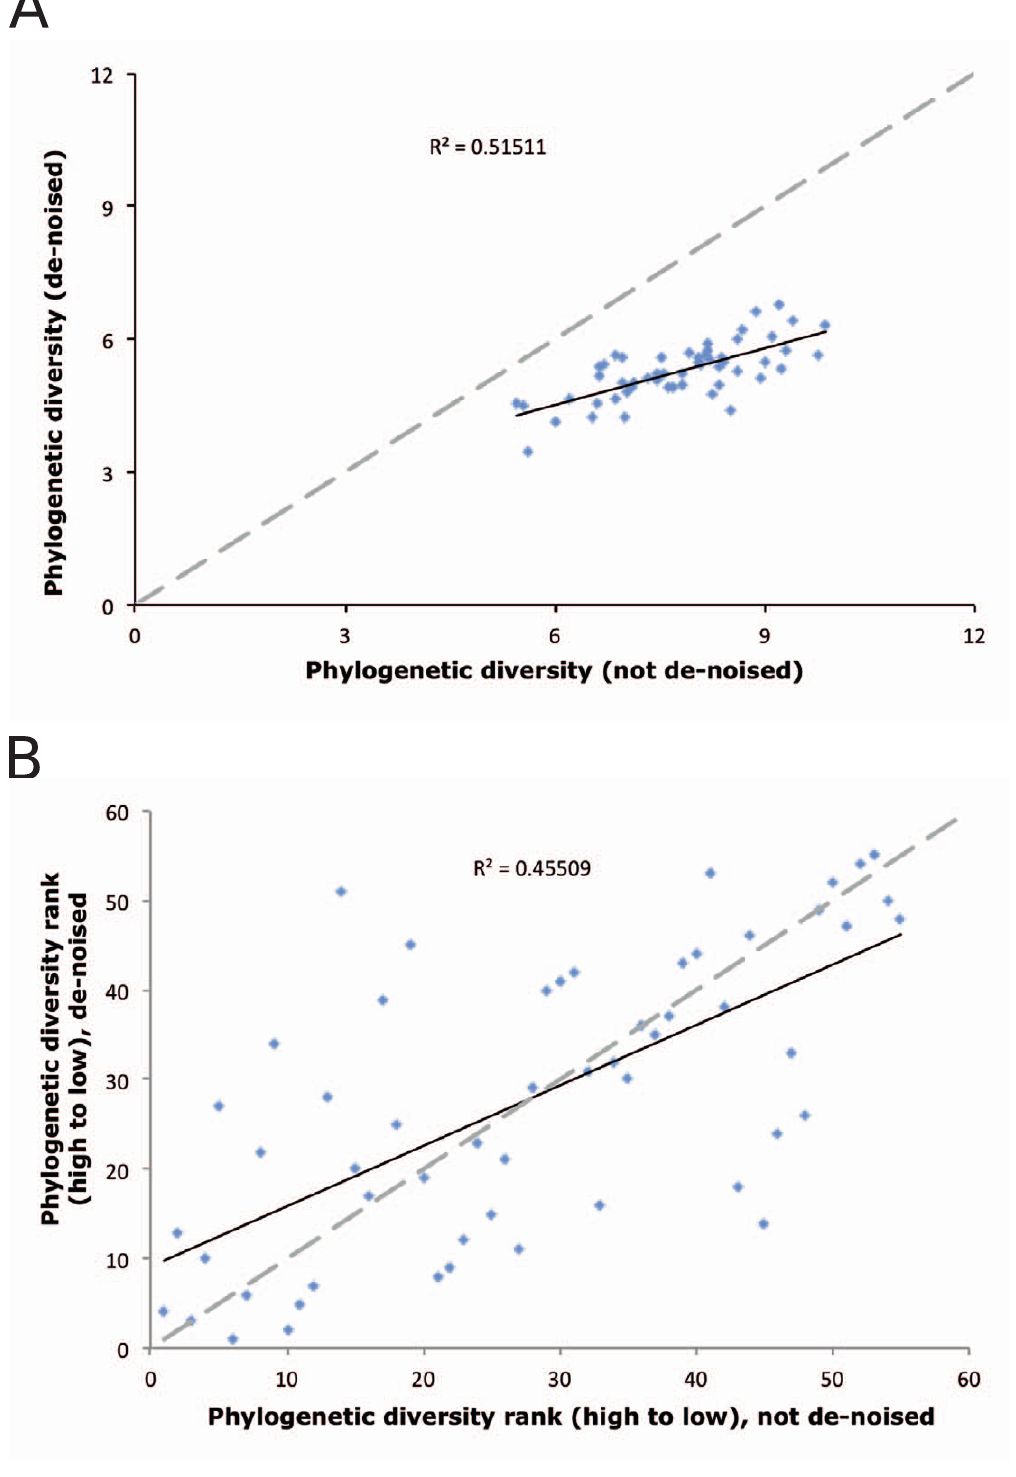
Figure 4. Impacts of de-noising on phylogenetic diversity. A) Relationship between phylogenetic diversity with and without de-noising, by sample. B) Ranking of samples by phylogenetic diversity with and without de-noising.